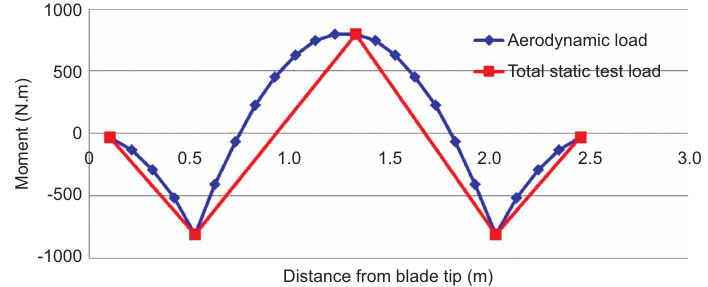
Figure 16 Static strength test loads simulated by the 3-point loading